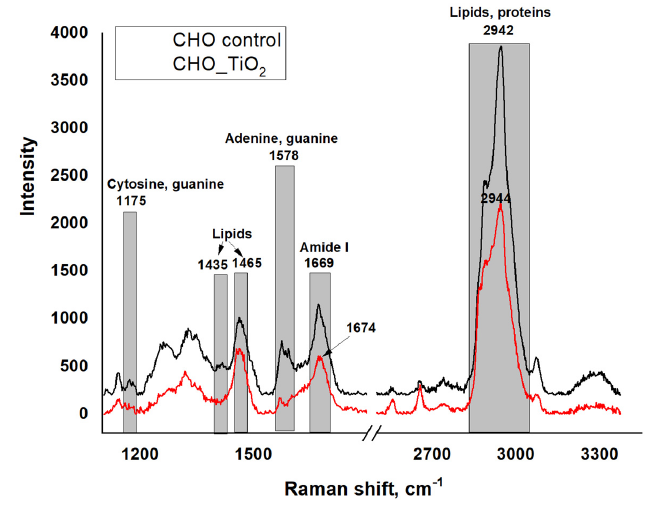
Figure 11. Raman spectra of CHO cells for control vs. after TiO 2 -NP treatment.